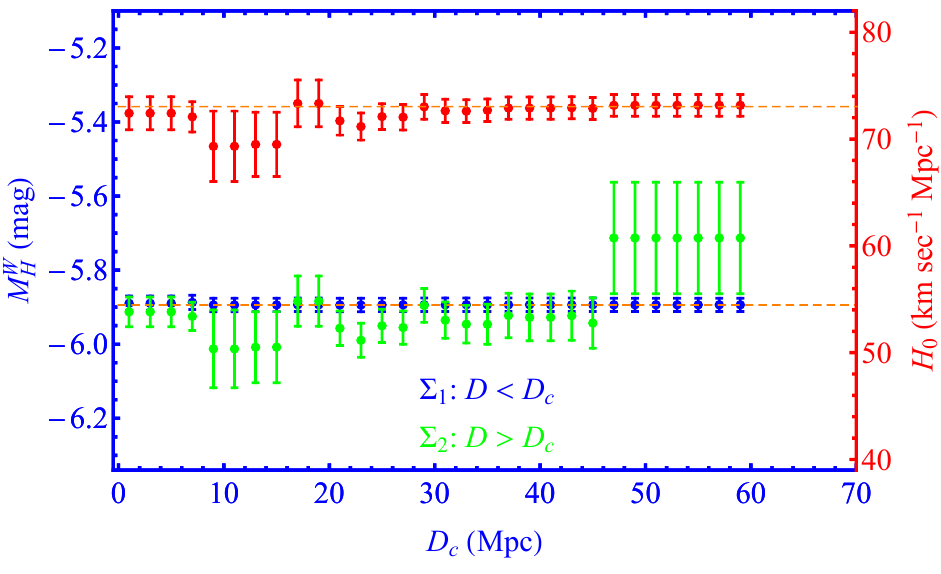
Figure 10. Same as Figure 8 in an analysis generalization, where the parameter M W is allowed to have a transition at a distance D c . Notice the sharp increase in the difference between best-fit parameters − M < | for D c > 47 of high D and low D bin | M > W W